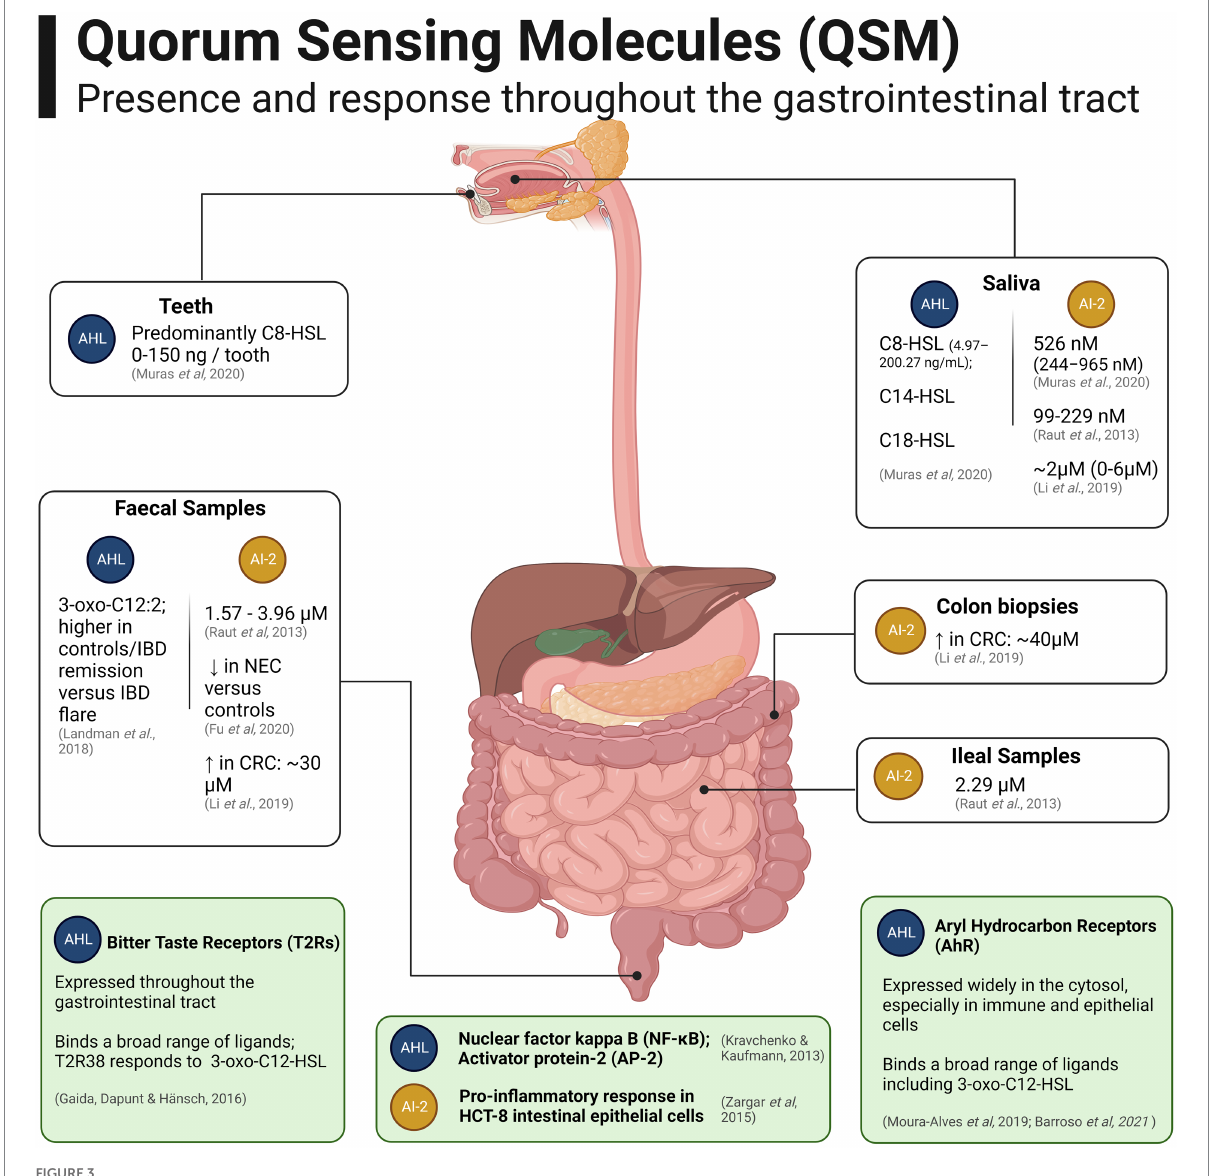
FIGURE 3 Quorum Sensing Molecules (QSM) which have been detected in samples from the human gastrointestinal tract (white boxes). Mammalian receptors present in the human gut capable of binding QSM as ligands are shown in light green boxes towards the bottom of the figure. Created with